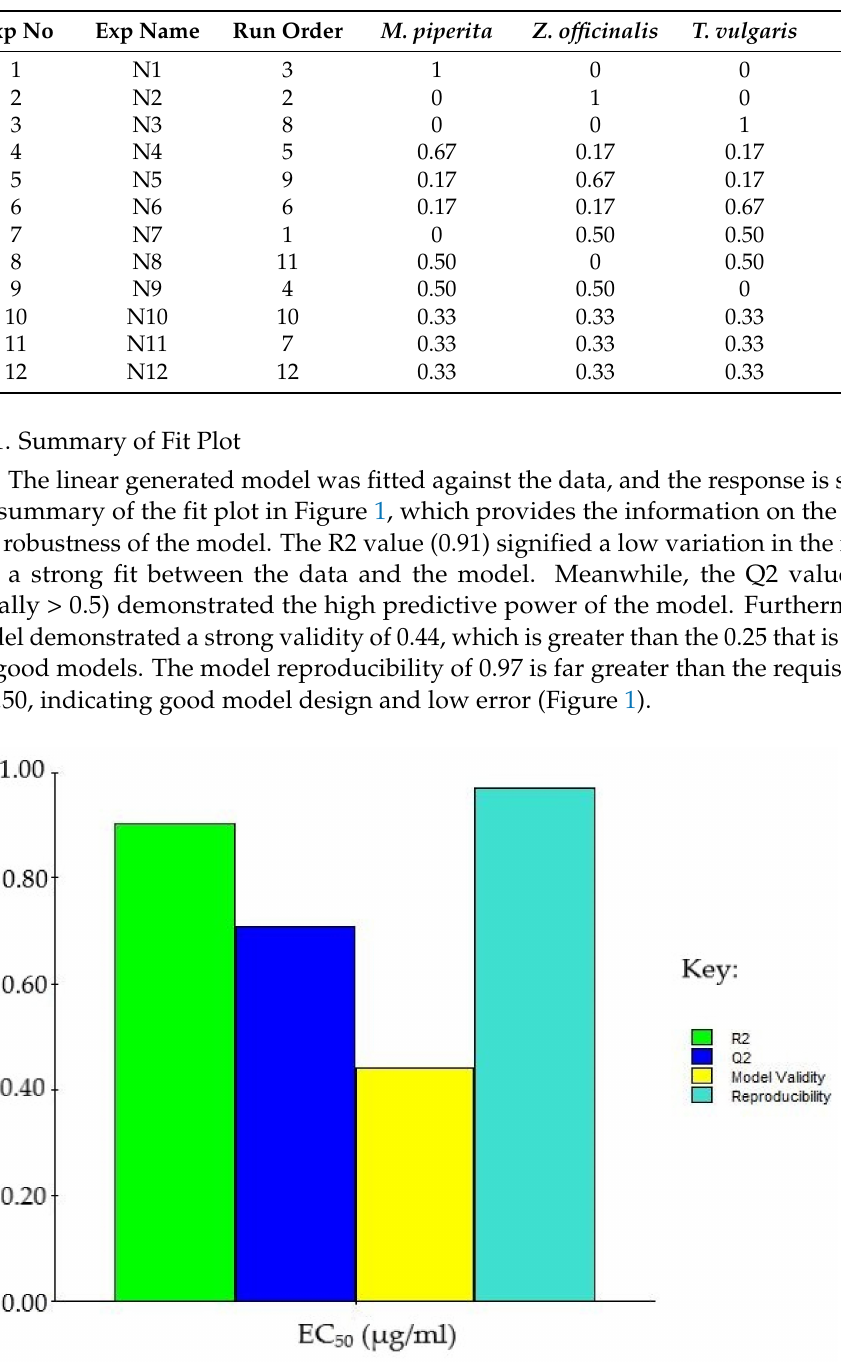
Figure 1. Summary of fit plot for EC 50 of methanol extract